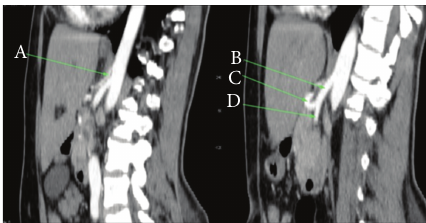
Figure 3: Sagittal reconstructed CT images demonstrating the new anatomic variant. Key: left gastric artery—A; unnamed common trunk—B; coeliac trunk—C; superior mesenteric